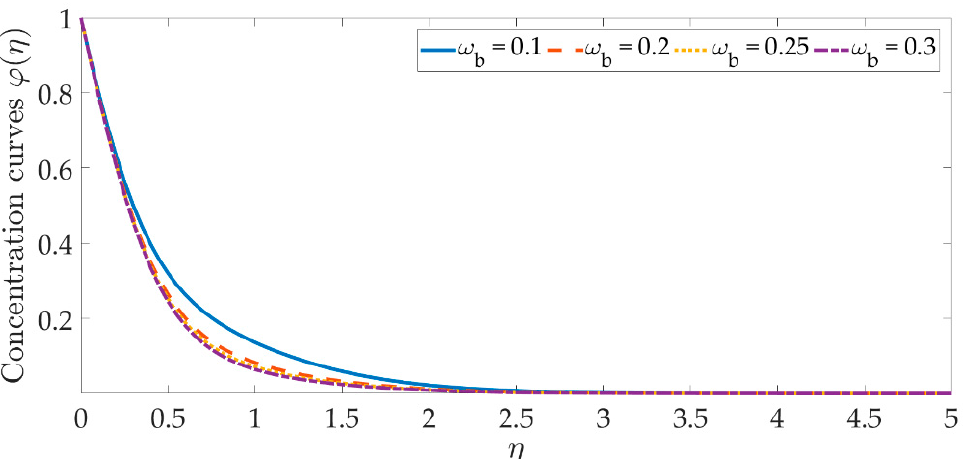
w w Figure 18. Concentration curves against the multiple values of ω b .